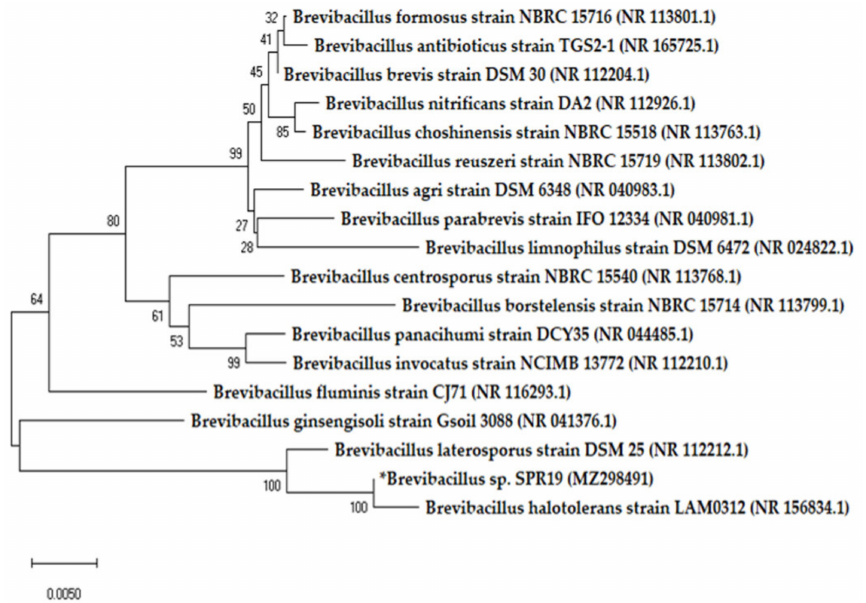
Figure 1. Phylogenetic tree of Brevibacillus sp. SPR19 based on 16s rRNA sequencing. The tree was constructed by MEGA X software with neighbor-joining analysis.